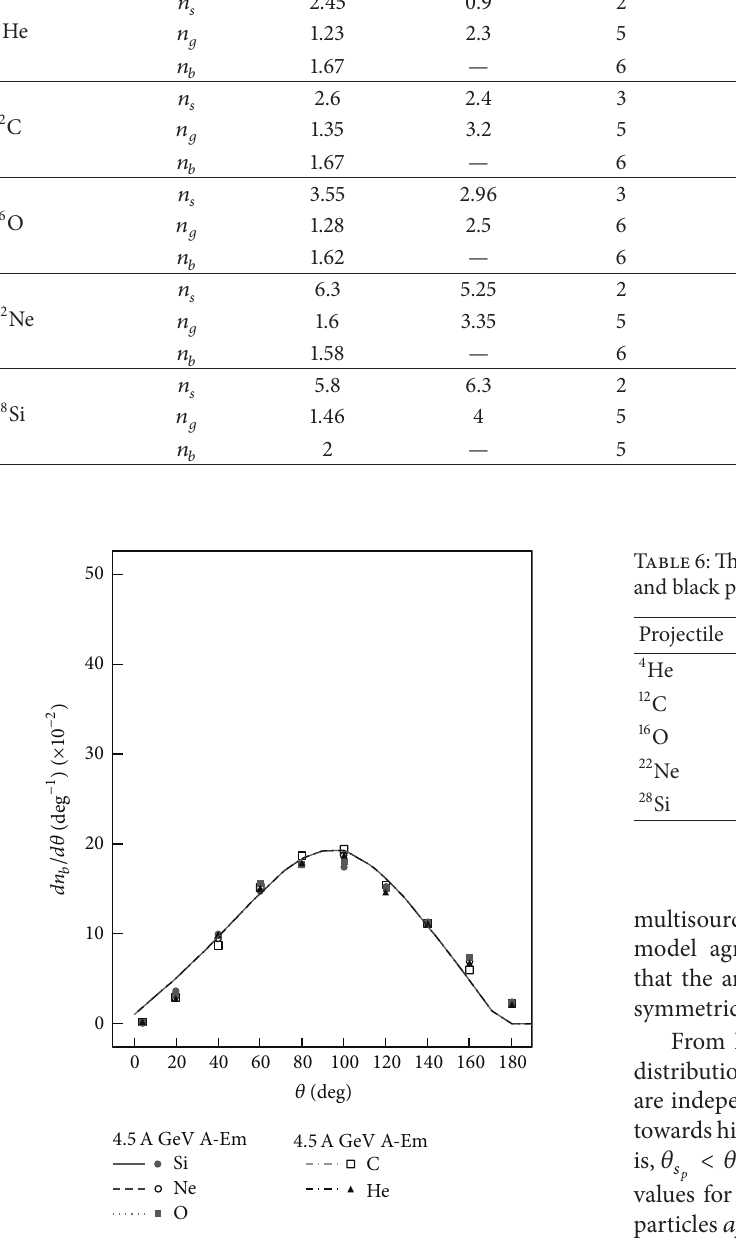
Figure 7: Angular distributions of black particle produced in 4 He- (solid triangle), 12 C- (open square), 16 O- (solid square), 22 Ne- (open circles), and 28 Si- (solid circles) Em collisions at (4.1– 4.5) AGeV/c. The symbols represent the experimental data. Capone the curves are our calculated results by multisource thermal model.